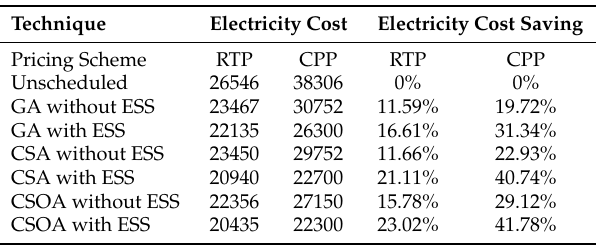
Figure 12. Total electricity cost using CPP signals. ( a ) Total electricity cost without ESS for a single smart home; ( b ) total electricity cost without ESS for 30 smart homes; ( c ) total electricity cost with ESS for a single smart home; ( d ) total electricity cost with ESS for 30 smart homes. Table 7. Summary of the results for thirty smart